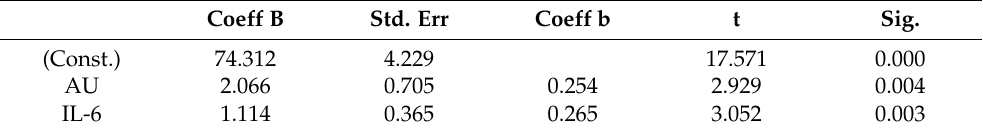
Table 3. Influence of biomarkers on